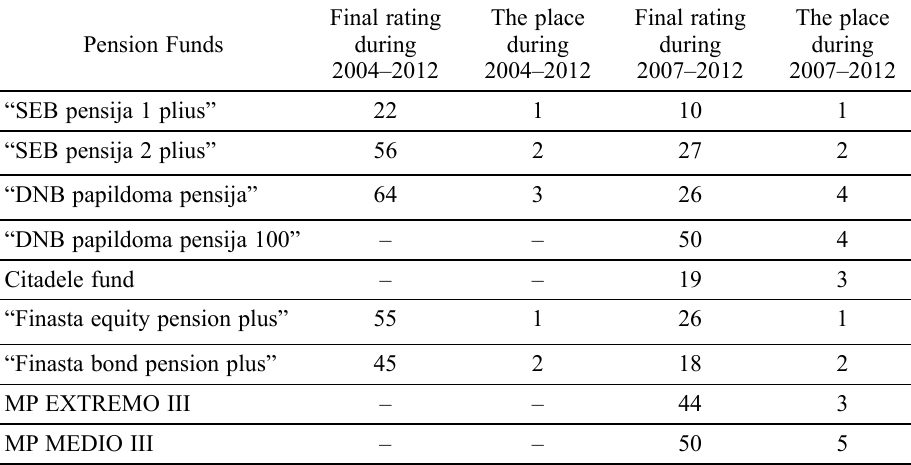
Table 6. Data of expert evaluation and weighing results of the 3 rd pillar PF evaluation criteria Pension Funds